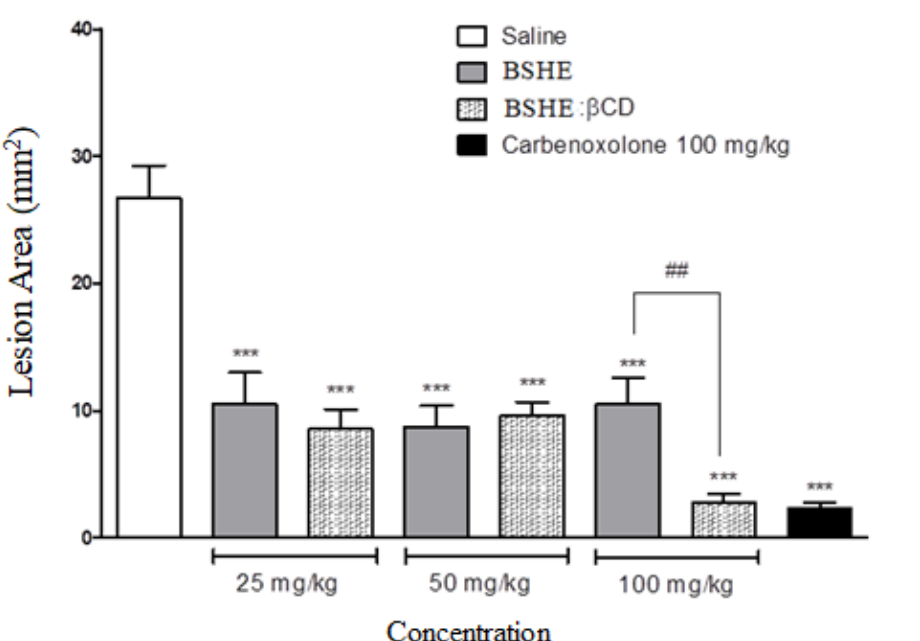
Figure 7. Analysis of gastroprotective activity BSHE: β -CD inclusion complexes in gastric lesions induced by absolute ethanol in mice. BSHE and BSHE: β -CD inclusion complexes were used at doses of 25, 50, and 100 mg/kg. For negative control, saline was used, and for positive control, carbenoxolone (100 mg/kg) was used. Data are expressed as mean ± E.P.M., *** p < 0.001, compared to control (ANOVA, followed by Tukey’s test), ## p < 0.01 comparing BSHE with BSHE: β -CD inclusion complexes.